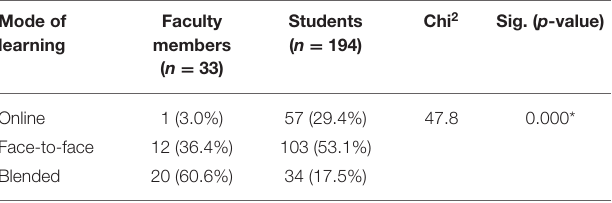
TABLE 2 | Comparison of responses of faculty members and students regarding preference of the mode of learning. Mode of